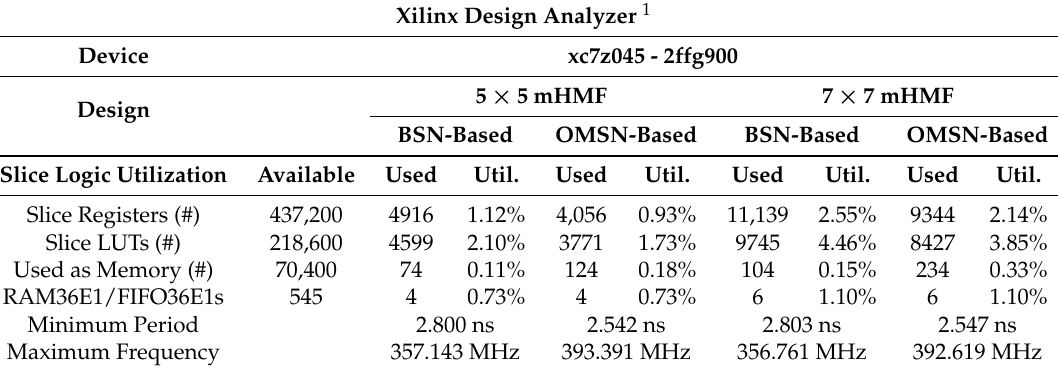
Table 9. Hardware synthesis results of different architectures for realizing the modified hybrid median filter with 5 × 5 and 7 × 7